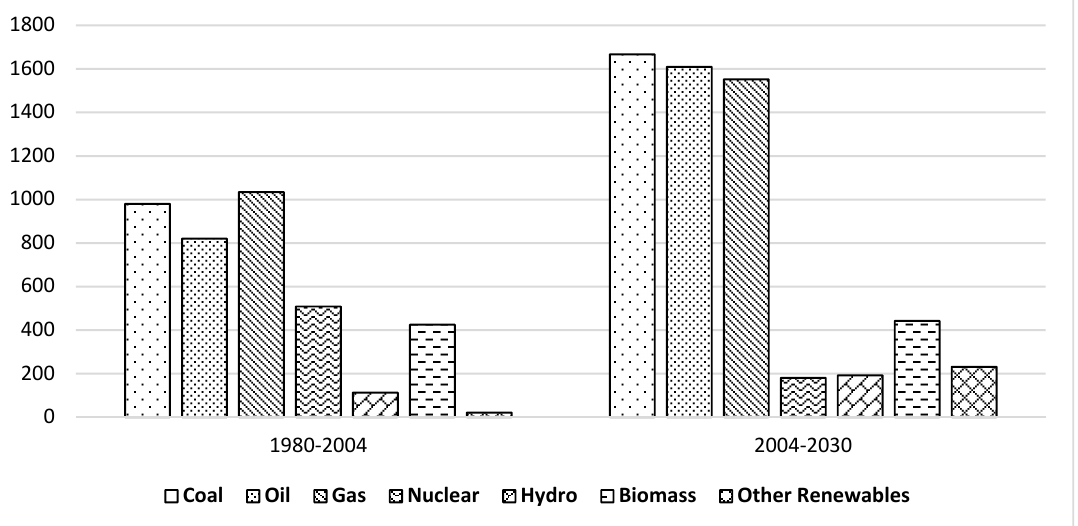
Figure 1. Increase in demand of energy resources.